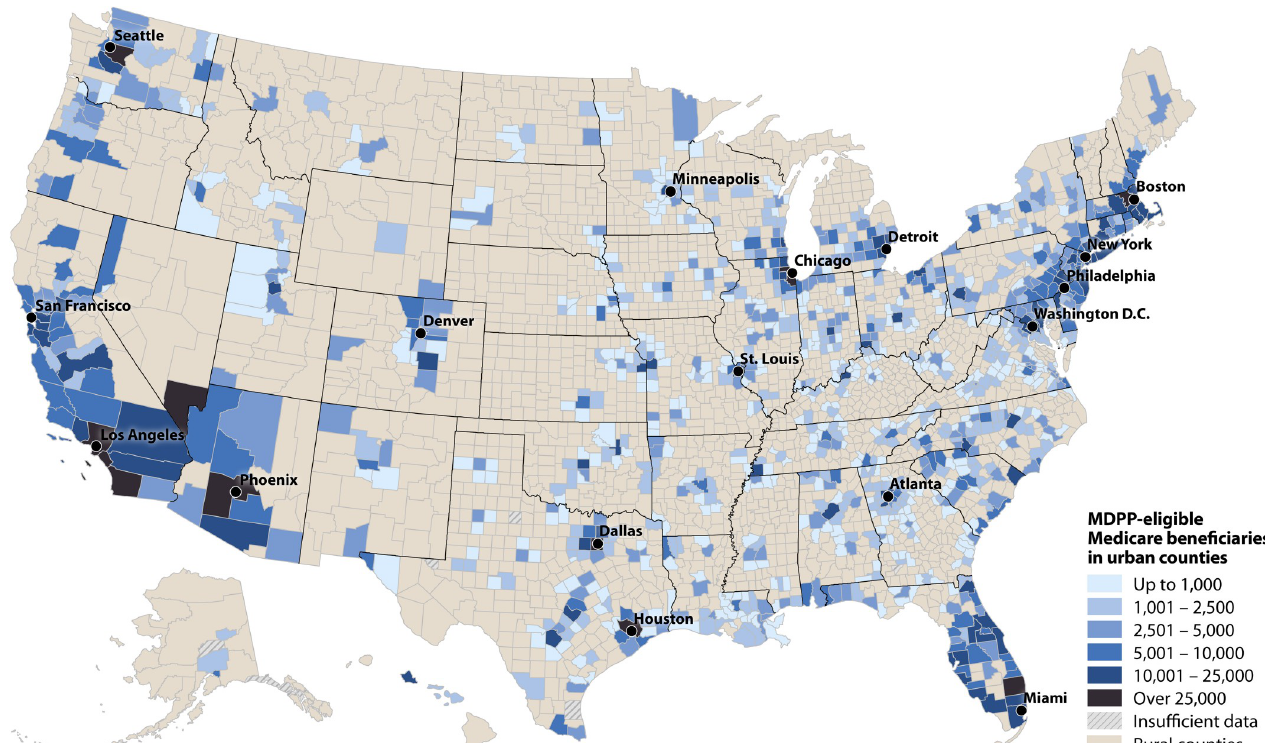
Fig 3. Estimated number of MDPP-eligible beneficiaries in urban counties,